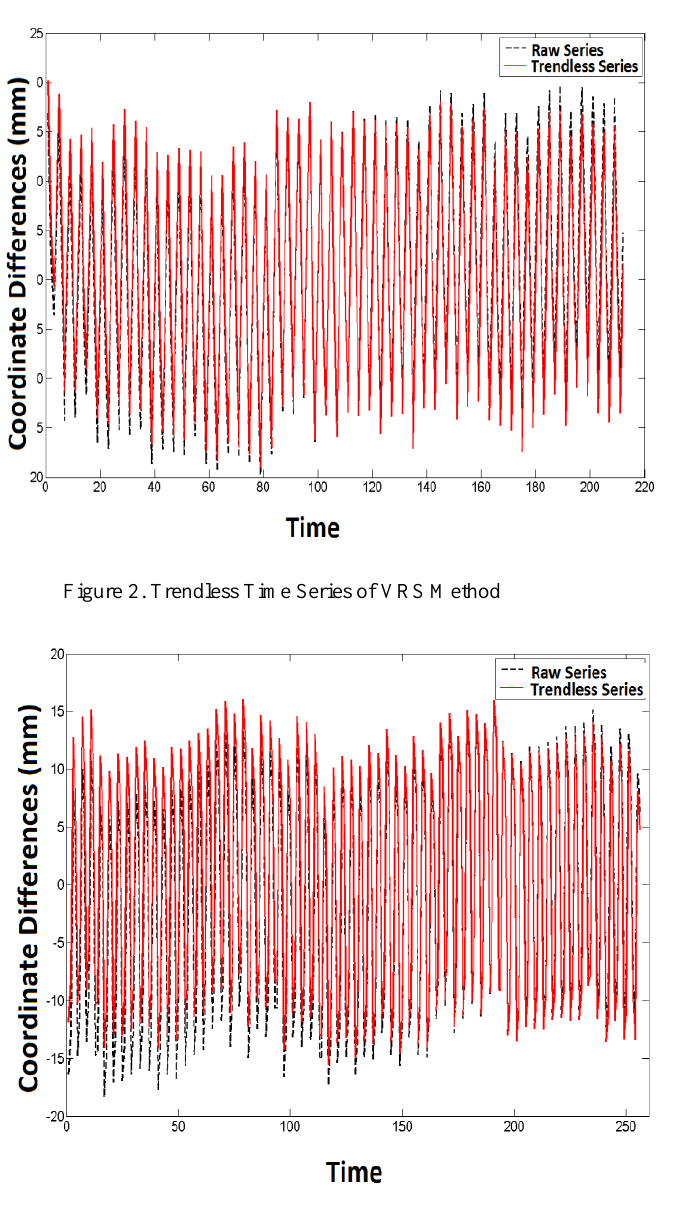
Figure 3. Trendless Time Series of FKP